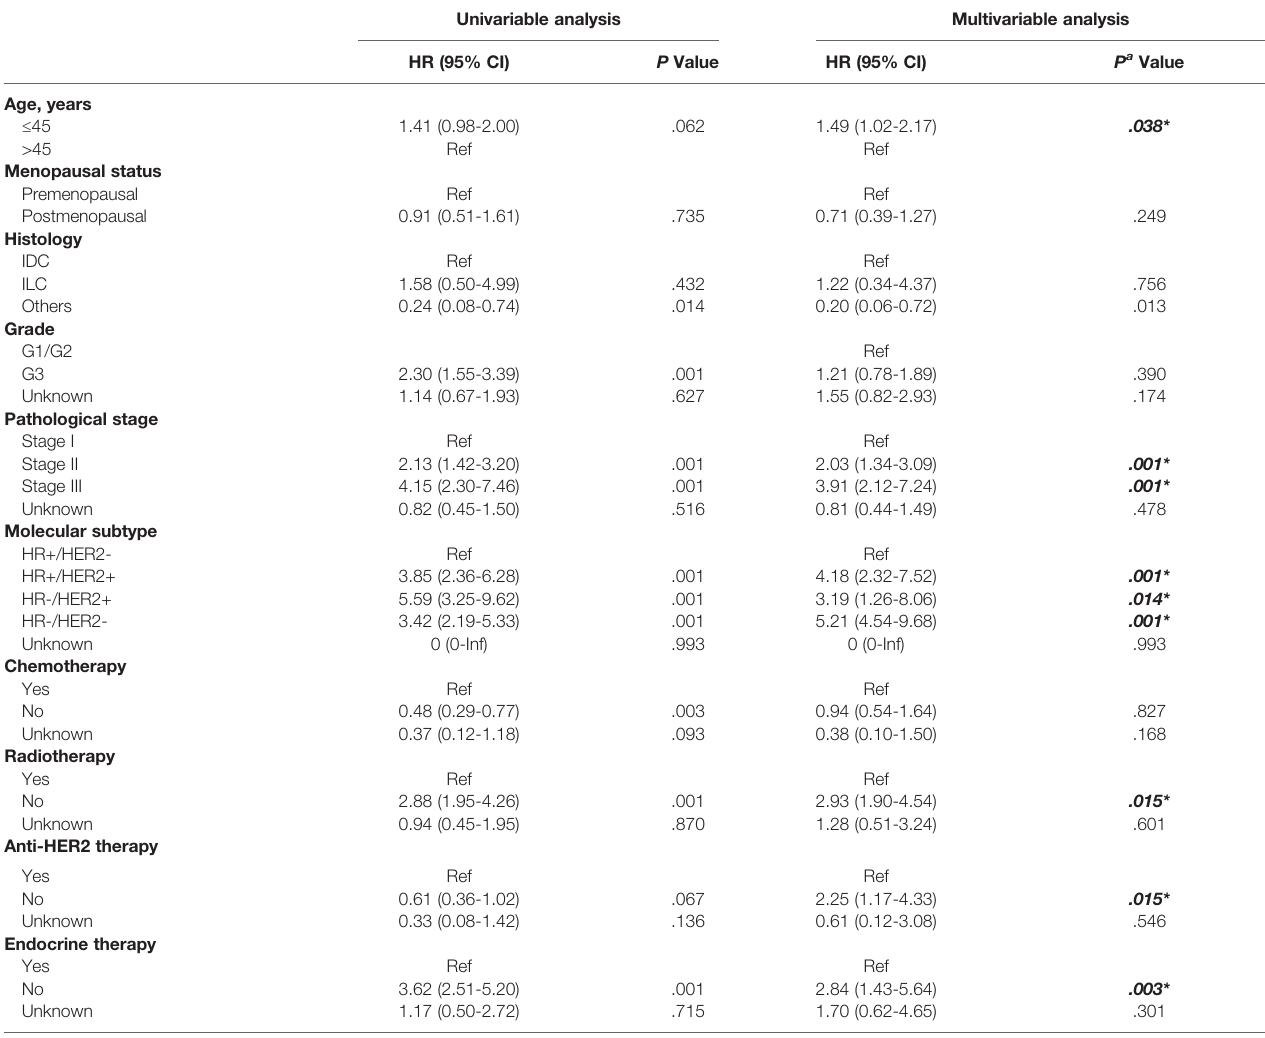
TABLE 2 | Factors predictive of loco-regional recurrence in patients treated with breast-conserving